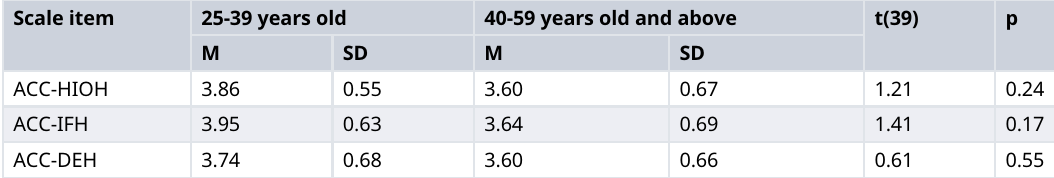
Table 3. Comparisons of mean scores of acceptance of eHealth domains for mental wellness between age groups using independent sample t-tests. Scale item